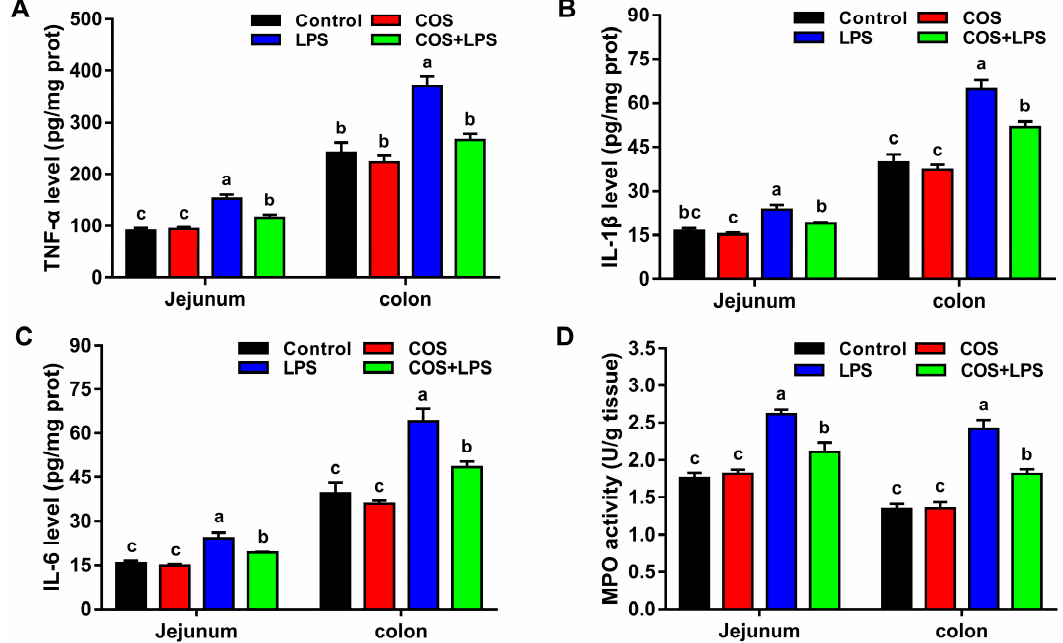
Figure 6. Effects of COS on inflammation in the jejunum and colon of mice. TNF- α ( A ), IL-1 β ( B ), IL-6 ( C ) levels and MPO activity ( D ) in the jejunum and colon. The data are presented as the mean ± SE ( n = 6–8). Values without a common letter are significantly different ( p < 0.05). COS, chitosan oligosaccharide; LPS, Lipopolysaccharide; prot, protein; TNF- α , tumor necrosis factor- α ; IL-1 β , interleukin-1 β ; IL-6, interleukin-6; and MPO, myeloperoxidase.